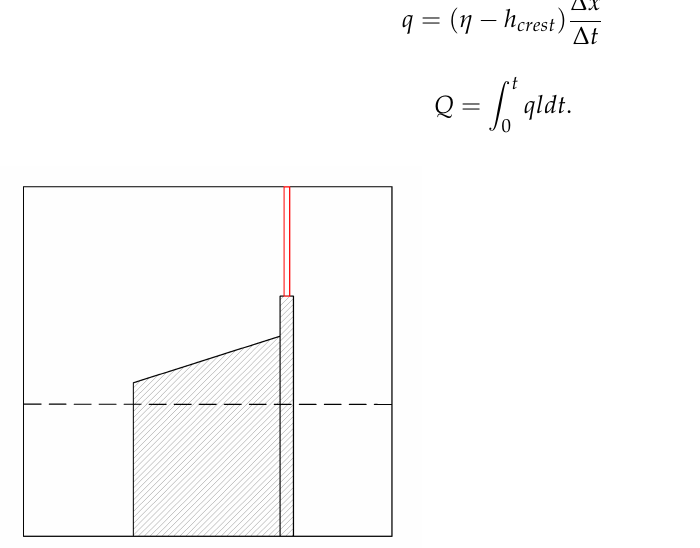
Figure 1. Illustration of flux of a vertical surface on the design wall for the calculation of overtopping. The red box shows the section of flux